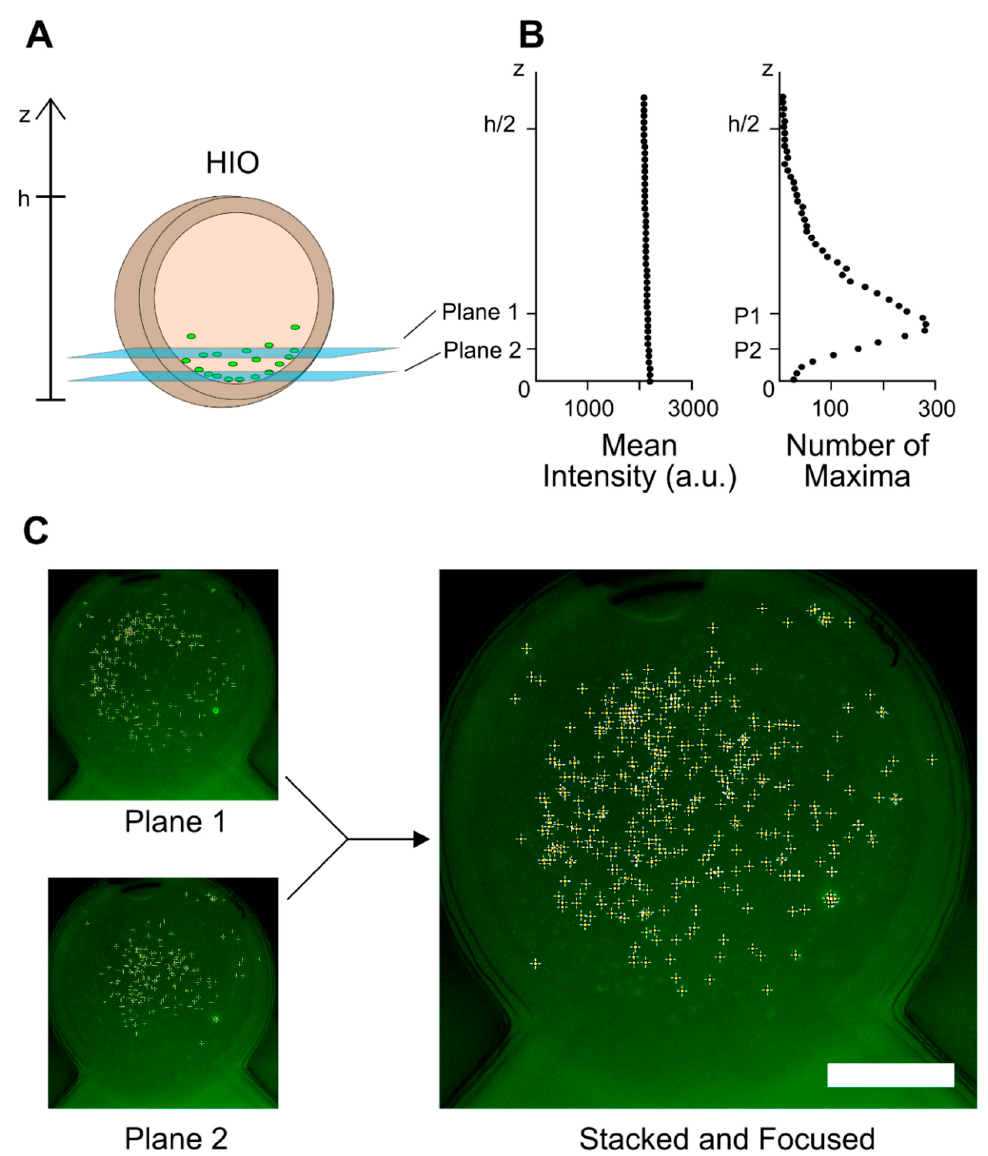
Figure 3. ( A ) The E. coli primarily resided on the lower luminal wall, so focal planes were selected to capture a maximal number of distinct bacteria. The plotted data is for one HIO. ( B ) Within the circular region defined by the HIO, mean fluorescence intensity and number of identified maxima are shown as a function of height z, with z = 0 corresponding to the bottom of the HIO. ( C ) Separate planes are flattened into a single plane for subsequent image analysis. Identified bacteria are marked with plus signs. Scale bar: 500 μ m.